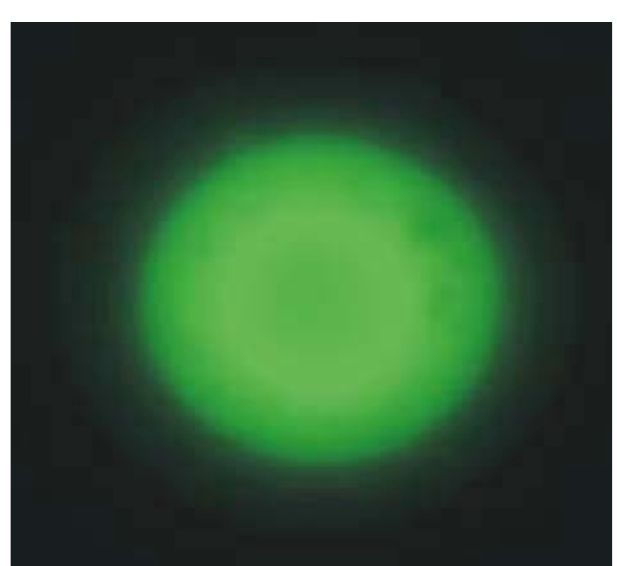
Figure 4 S2 cells transfected with GFP inserted in the pEXII expression vector. The overall staining of the cells expressing GFP only is clearly visible. Also the nucleus shows green fluorescence in contrast to the cells expressing wild type P0-GFP fusion protein (see fig.